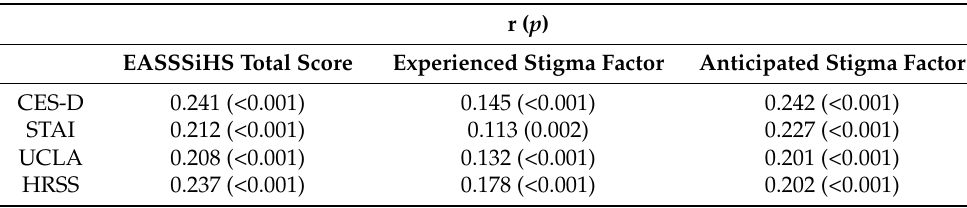
Table 4. Concurrent validity of the Experienced and Anticipated Sexual Stigma Scale in Health-care Services (EASSSiHS). r ( p ) EASSSiHS Total Score Experienced Stigma Factor Anticipated Stigma Factor CES-D 0.241 (<0.001) 0.145 (<0.001) 0.242